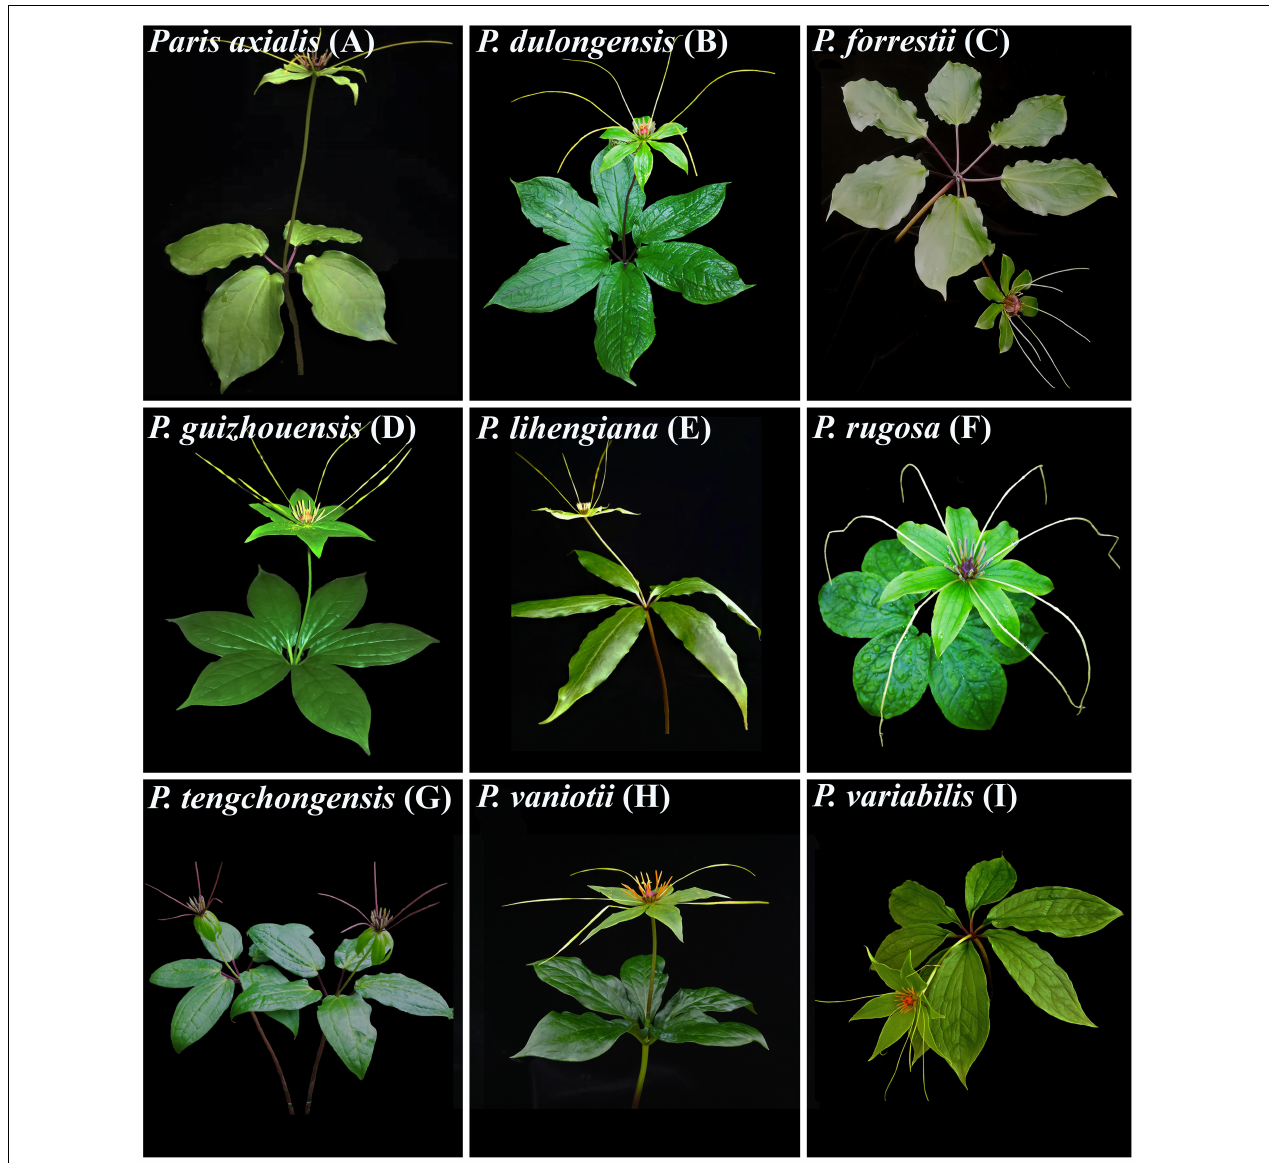
FIGURE 1 | Nine nominal species within Paris section Axiparis , showing their leaf size and shape variations. Paris axialis (A) , P. dulongensis (B) , P. forrestii (C) , P. guizhouensis (D) , P. lihengiana (E) , P. rugosa (F) , P. tenchongensis (G) , P. vaniotii (H) , and P. variabilis (I) .